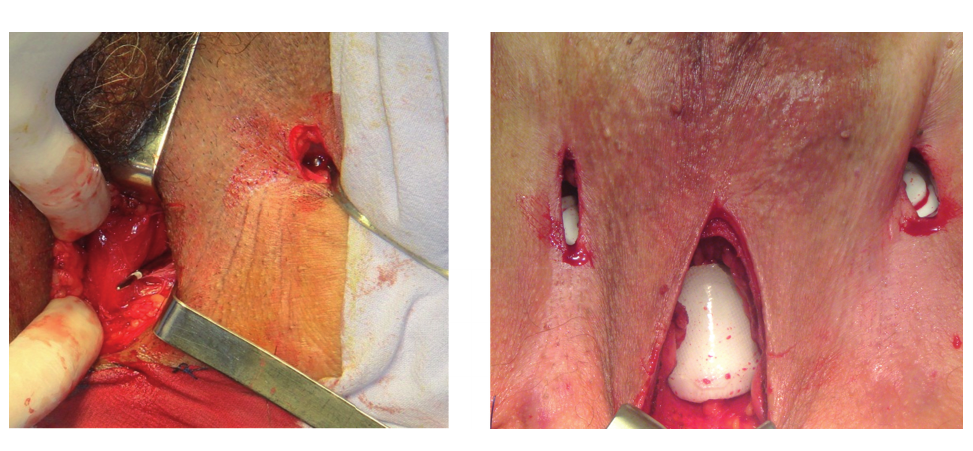
Figure 2 - Left - tip of left needle in the perineal wound. Right – Implant: Pad, Rings and hidden fi xation arms, in fi nal position after the RLPP measure.